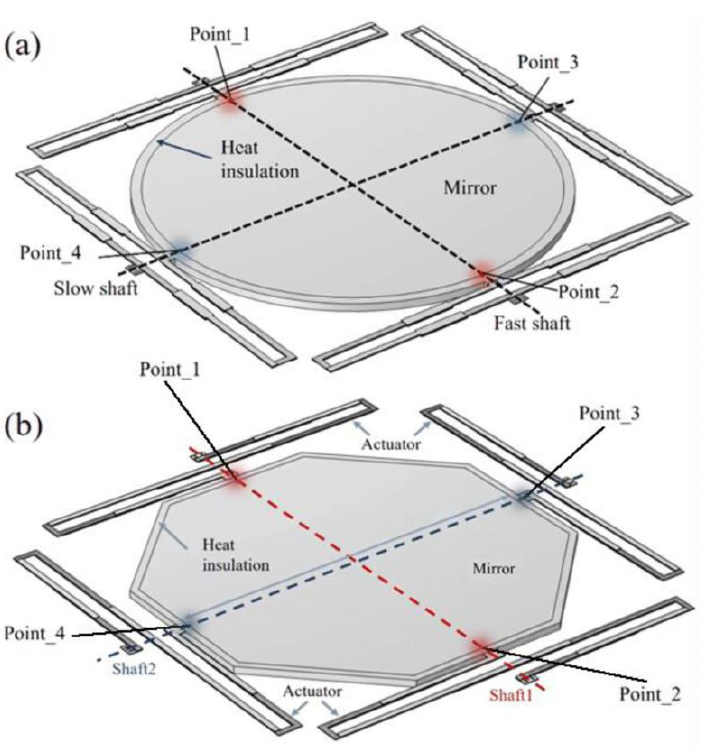
Figure 3. The micromirrors. ( a ) “ O ” type. ( b ) “ Z ” type.